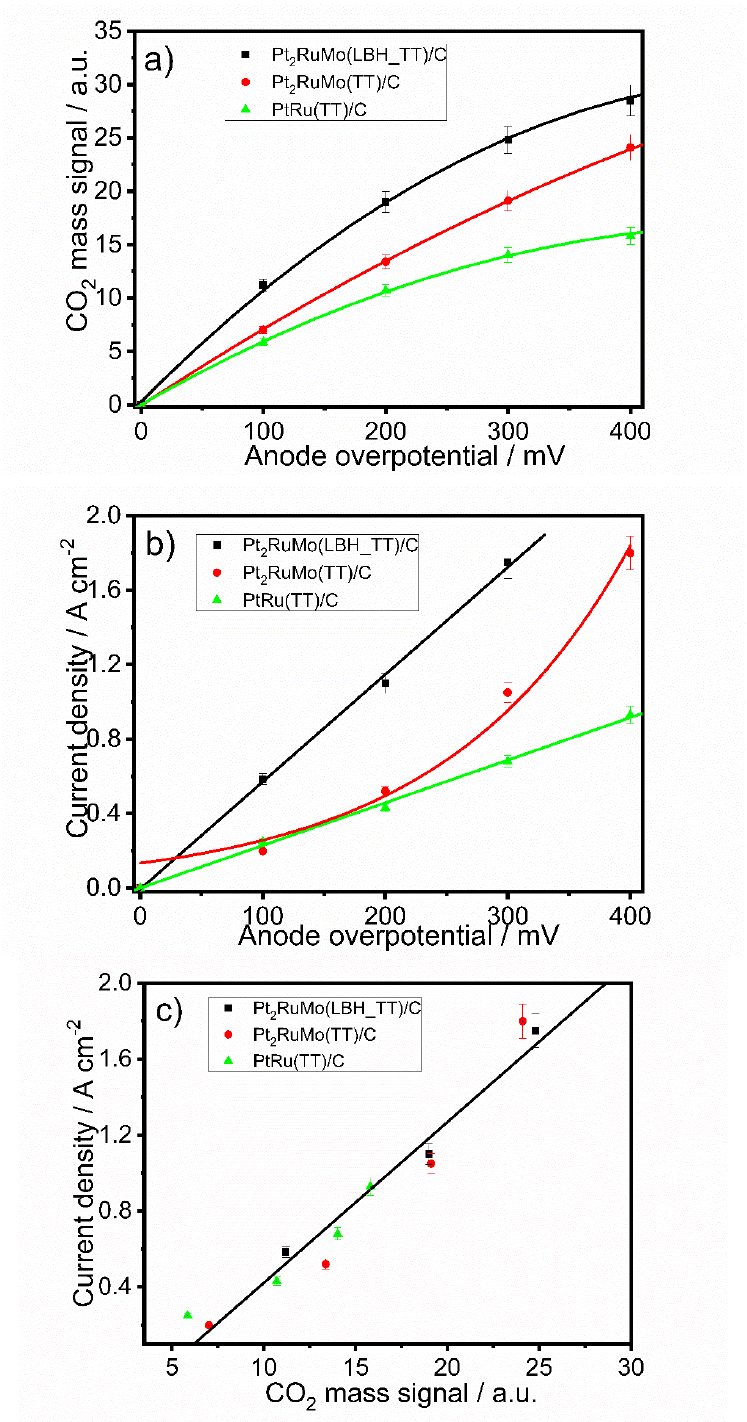
Figure 8. CO 2 mass signal ( a ) and current density ( b ) vs. anode overpotential. Current density vs. CO 2 mass signal ( c ).